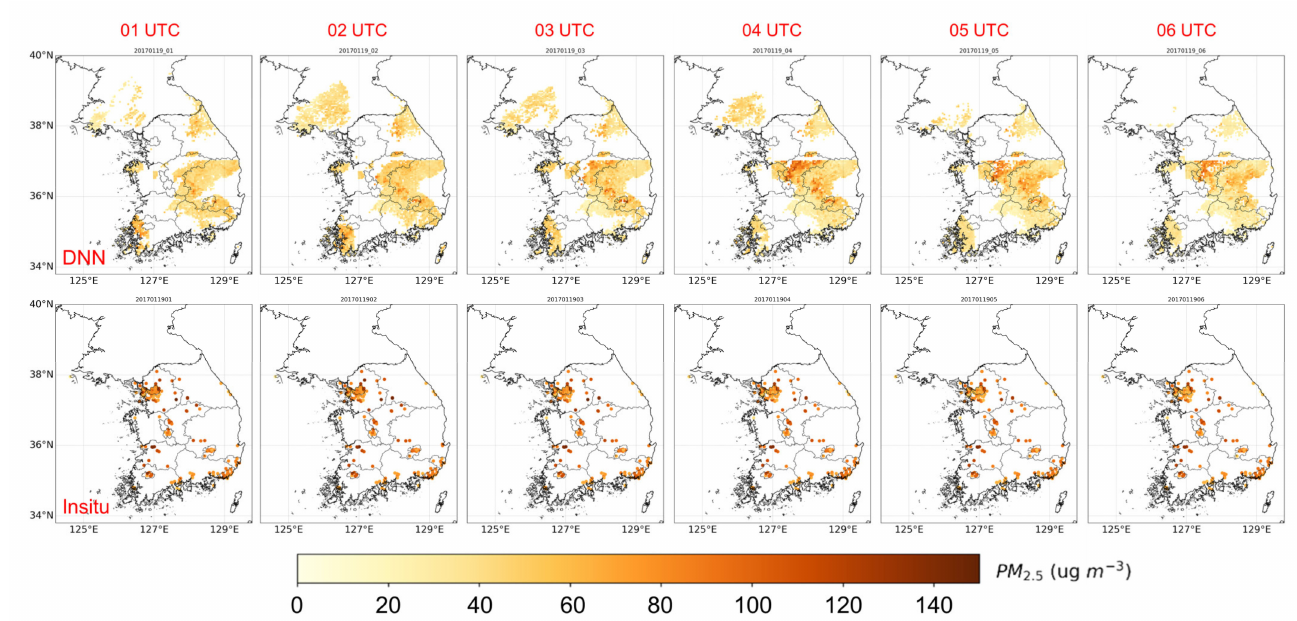
Figure 4. Spatial distributions of ground-level PM 2.5 concentrations on 19th January 2017 (from 01:00 to 06:00 UTC). The top row figures are hourly spatial maps of PM 2.5 from the DNN, and the bottom row figures are the corresponding spatiotemporal measurements of PM 2.5 from selected ground